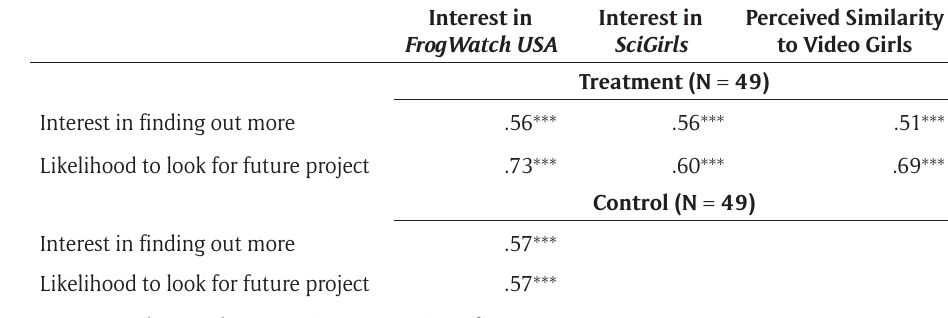
Table 4: Spearman correlations between interest ratings for groups. *** p ≤ .001.